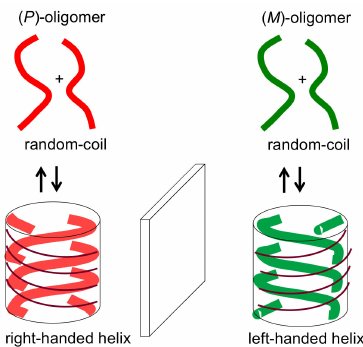
Figure 5. Formation of chiral double-helix cylindrical molecular complexes, shown in transparent blue.